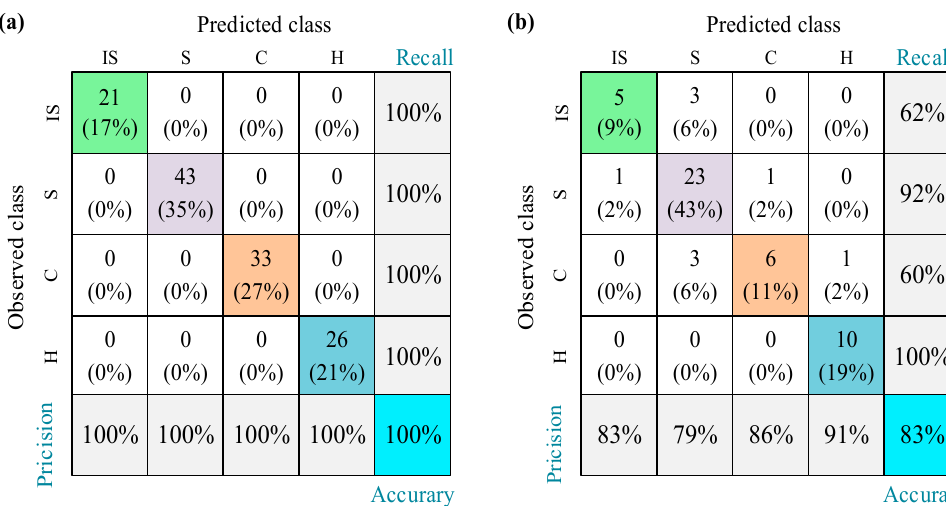
Figure 3. Confusion matrix of an RF classifier model for the fire risk database of stadium: ( a ) training set and ( b ) test set (IS: Ideal Safety, S: Safety, C: Critical, and H: Hazardous).